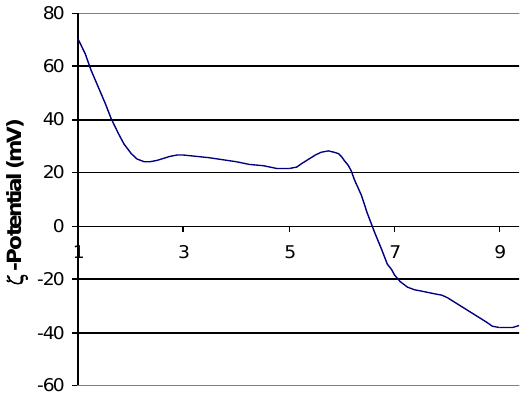
Figure 2. Zeta (  ) Potential surface charge of as-purchased single-walled carbon nanotubes (SWNTs) at pH 1 to